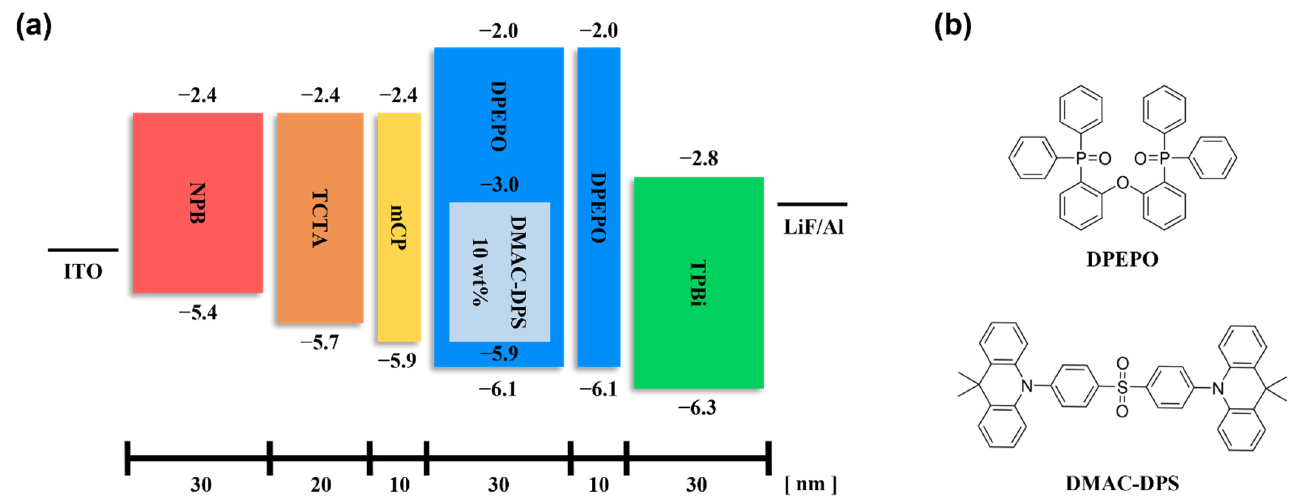
Figure 1. ( a ) Energy-diagram and structure of blue TADF OLEDs and ( b ) chemical structures of organic materials used in the EML.